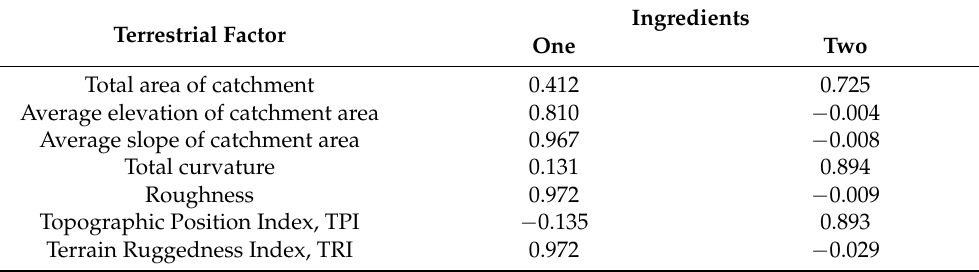
Table 10. Characteristic vector table of local factors, principal component analysis.